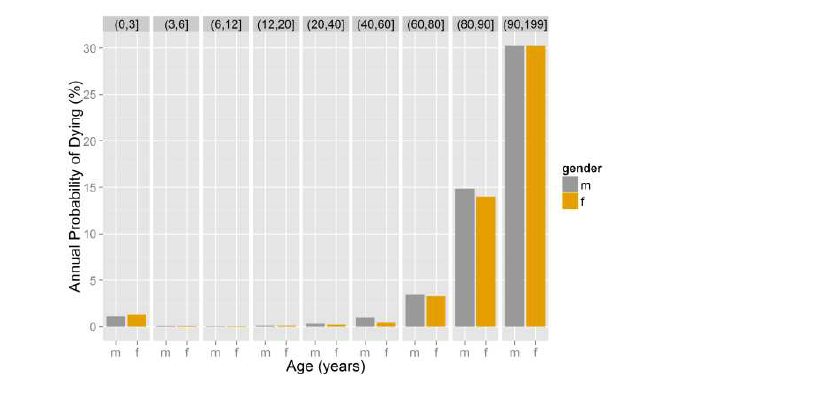
Figure A1.5: Mortality model from the Chitwan ABM. The annual probability of dying is empirically derived based on monthly data from the CVFS, and calculated independently for males and females in a number of different age